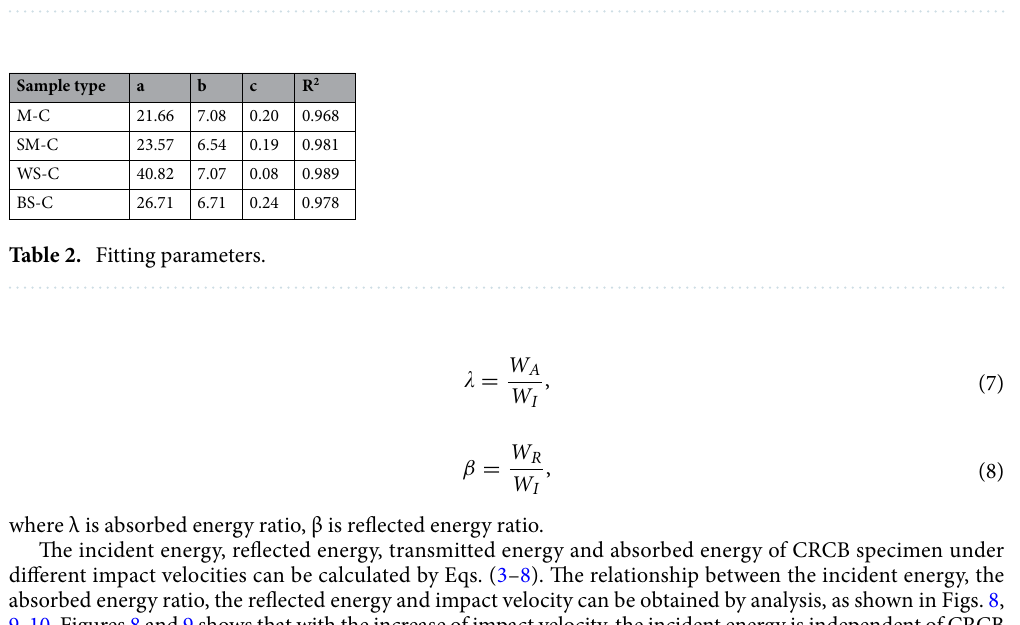
Figure 7. The dynamic strength and peak strain versus impact velocity for different CRCB specimens.